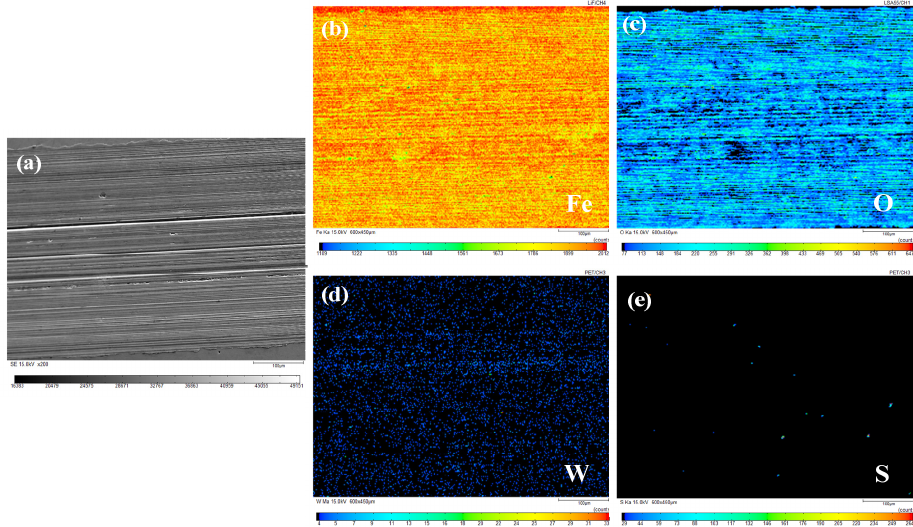
Figure 11. Element distribution diagram of wear scar corresponding to sample oil #1 (load: 100 N, sliding speed: 15 mm/s). ( a ) Scanning image; ( b ) Element Fe; ( c ) Element O; ( d ) Element W; ( e ) Element S.